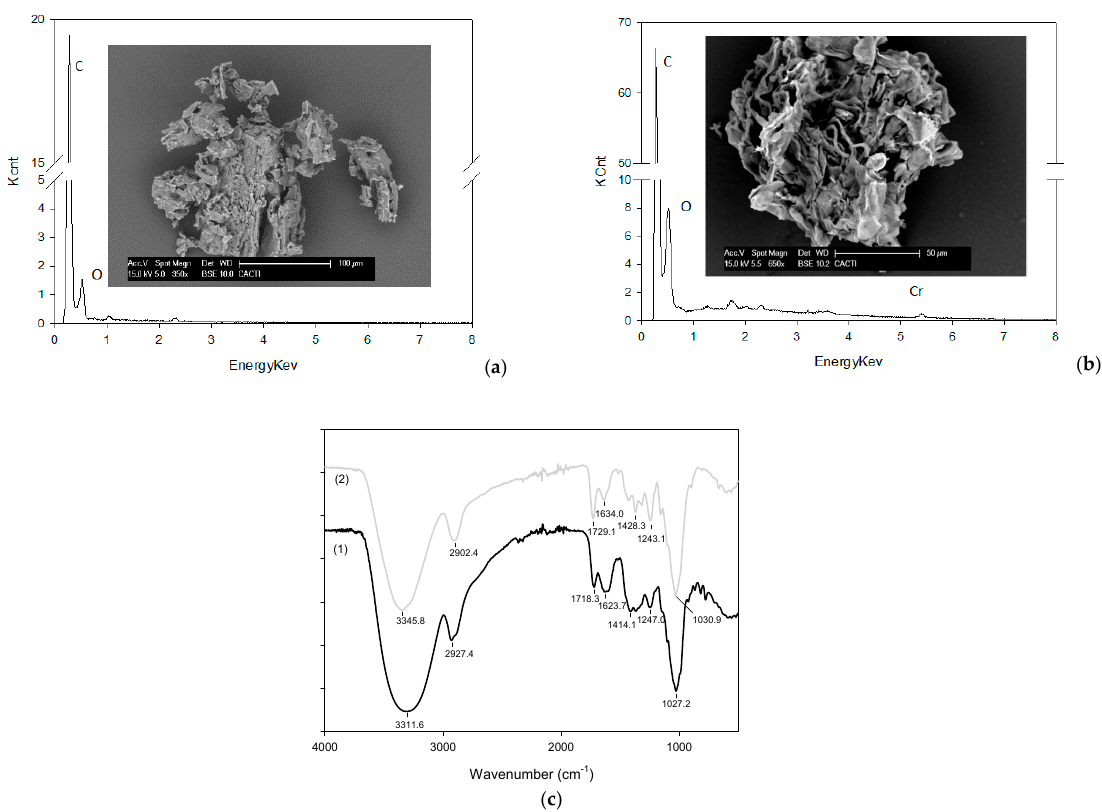
Figure 2. Characterization of PP waste: EDS energy spectrum and SEM image (inset photos) ( a ) initially and ( b ) after Cr adsorption and ( c ) pineapple core FTIR spectra initially (1) and after the adsorption (2).